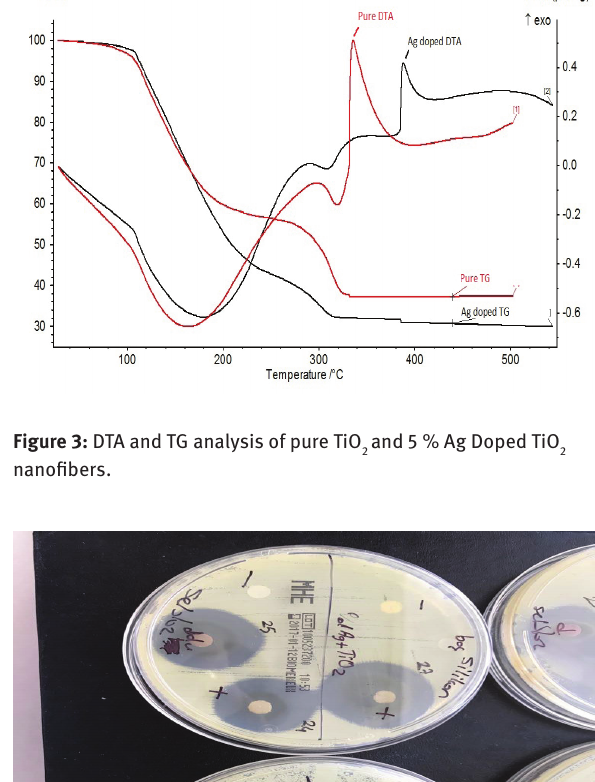
Figure 2: XRD Patterns of (a) Pure TiO